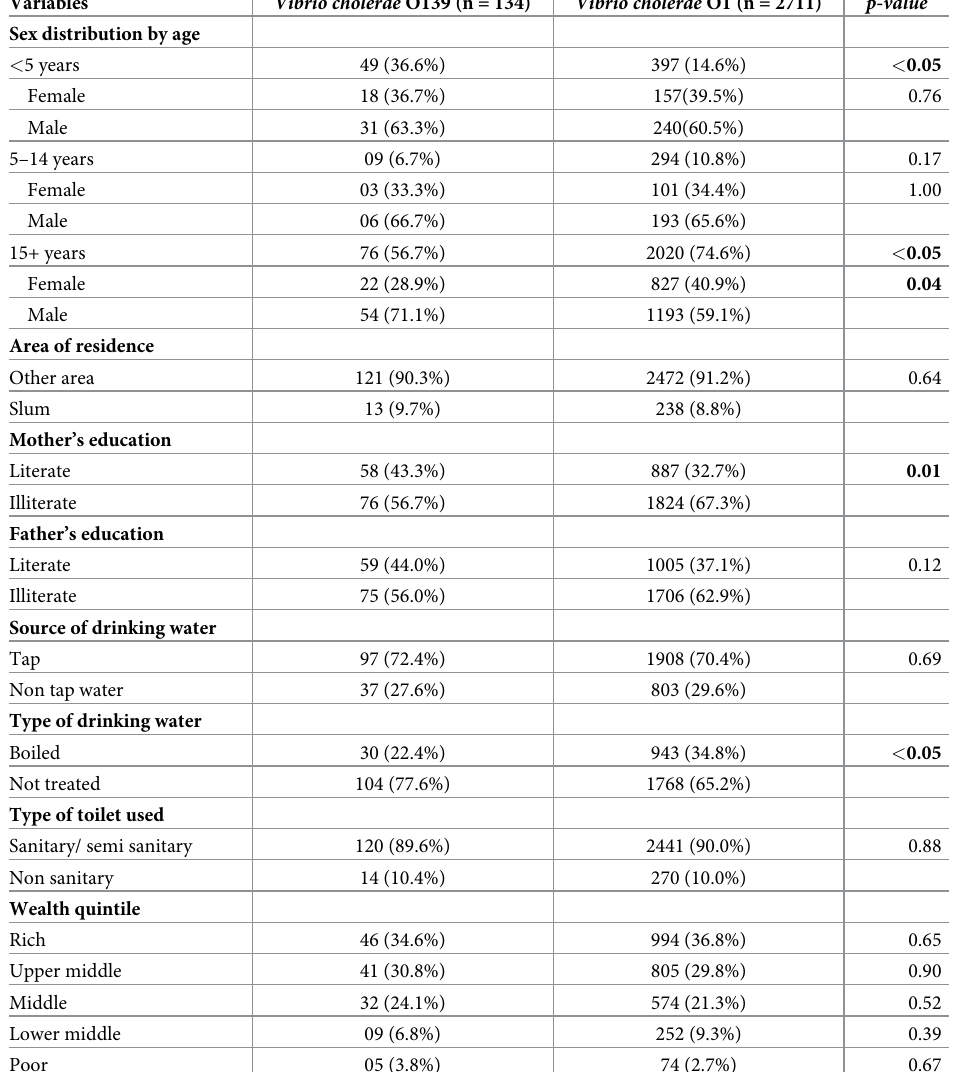
Table 2. Baseline characteristics of the cholera patients by serogroup Vibrio cholerae O139 and Vibrio cholerae O1 attended to the Dhaka Hospital of icddr,b; Bangladesh